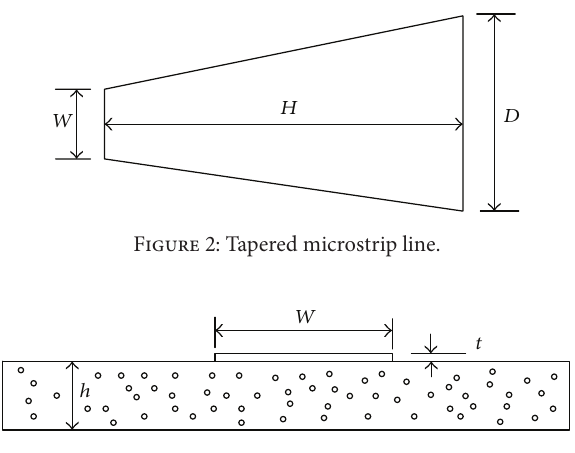
Figure 3: Microstrip line